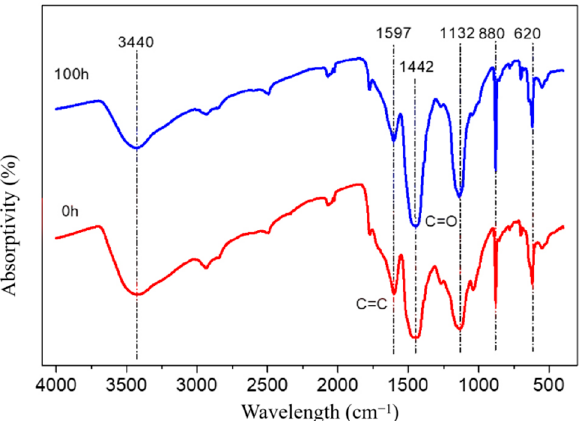
Figure 6. Infrared spectra of acid lake blue V dyes before (the red line) and after (the blue line) UV radiation.